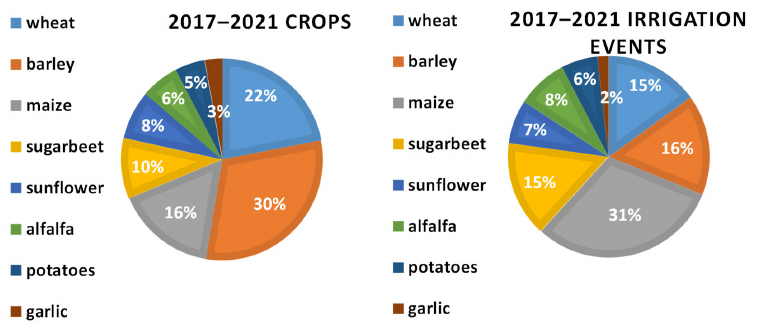
Figure 2. Left panel : percentage of main crops with an extent larger than 2 ha irrigated from 2017 to 2021. Right panel : percentage of irrigation events per crop ( right panel ).